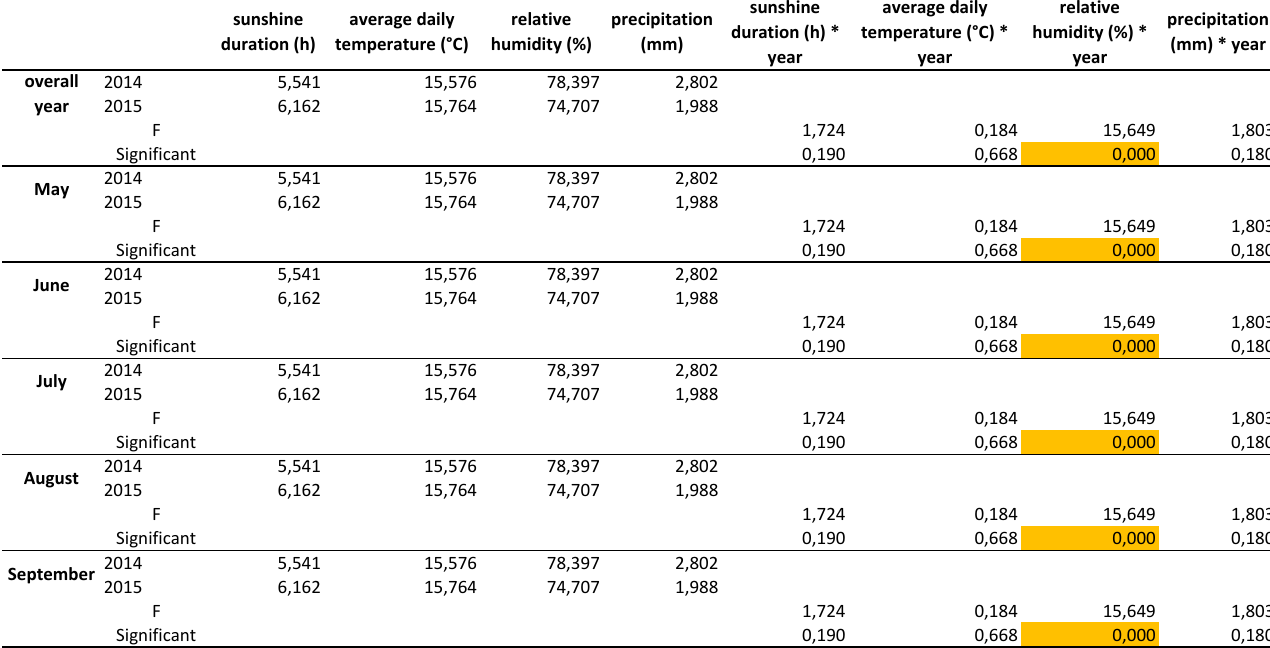
Table S8: Averaged results of sunshine duration, average daily temperature, relative humidity, and precipitation along with results of two-sided analysis of variance (ANOVA) performed for the categorical variables and “year”.